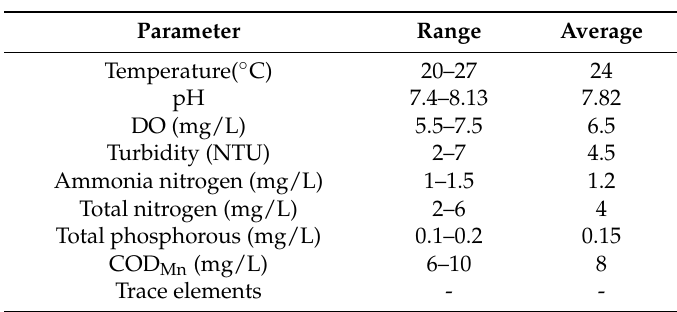
Table 1. Raw water